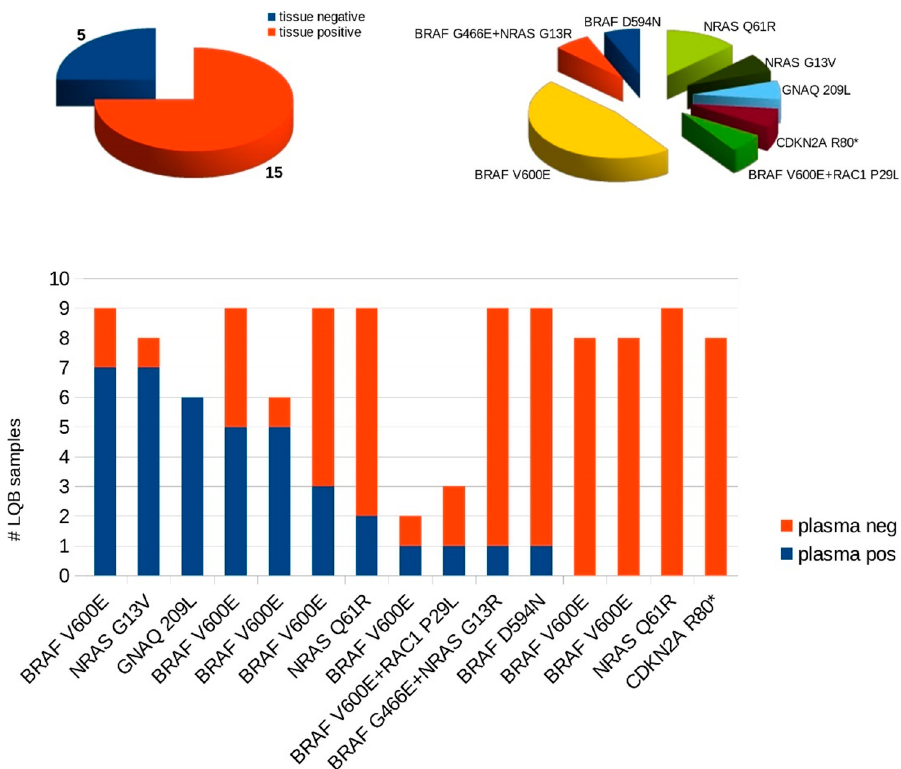
Figure 2. Pie charts showing ratio of tissue positive to tissue negative patients in our cohort ( n = 20), as well as proportions of detected cancer-associated mutations in tissue specimens. Bar chart illustrates number of ctDNA positive or negative plasma samples per patient in tissue positive patient cohort ( n = 15). Each bar chart represents one patient. #LQB, cumulative number of liquid biopsy samples; *, stop mutation.